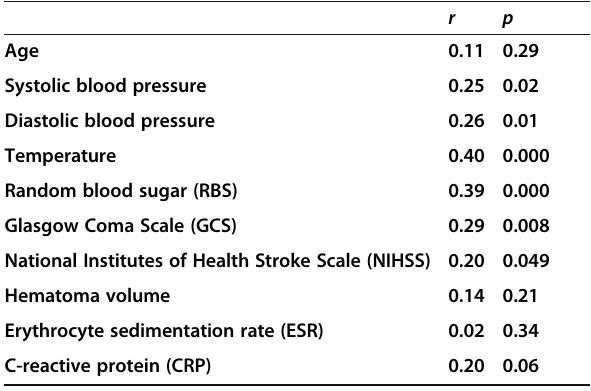
Table 3 Correlation between our study parameters and neutrophil-to-lymphocyte ratio